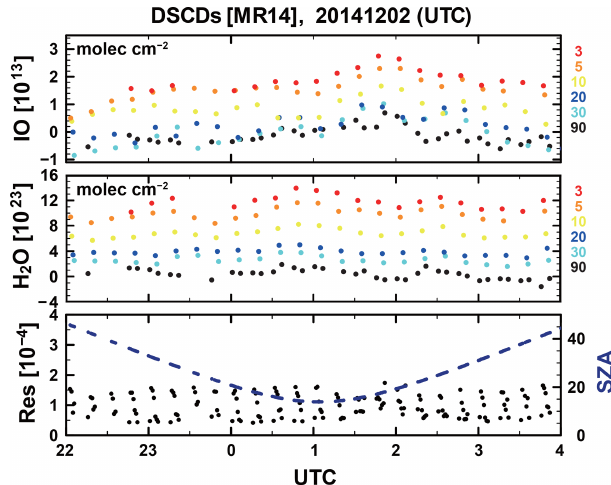
Figure 2. Time series of IO and H 2 O differential slant column den- sities (DSCDs) for elevation angles of 3, 5, 10, 20, 30, and 90 ◦ , the root mean square residual, and the solar zenith angle observed on 1–2 December 2014 over the tropical Western Pacific. Table 1. Cross sections of iodine monoxide (IO) and O 4 differential slant column densities used for this